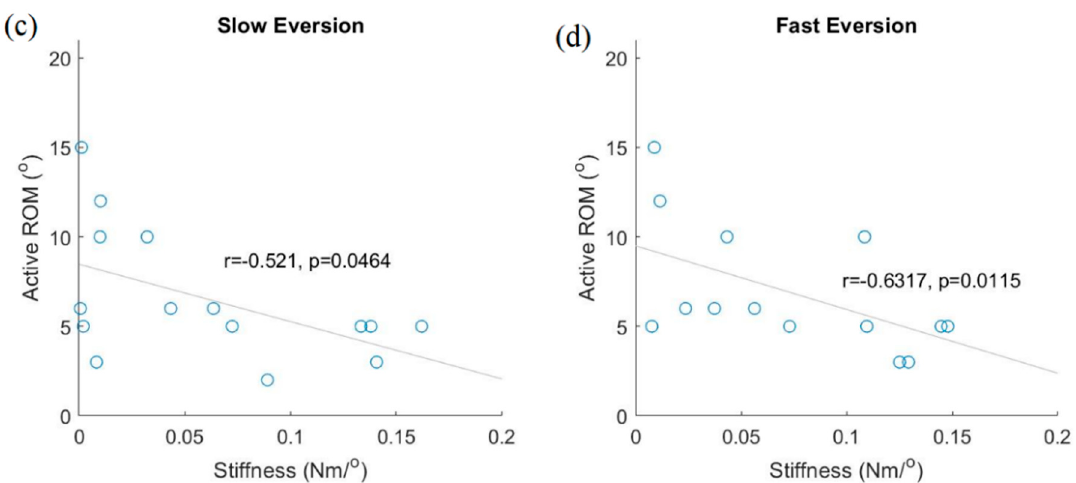
Figure 3. Relationship between active ankle range of motion (ROM) and ankle plantar flexion stiffness. Active plantar flexion ROM vs. ankle stiffness in plantar flexion: slower speed ( a ); faster speed ( b ). Active eversion ROM vs. ankle eversion stiffness: slower speed ( c ); faster speed ( d ).